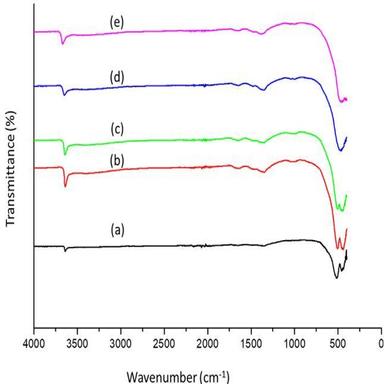
FTIR spectra of (a) Ni(OH)2, (b) Ni0.95Mg0.05(OH)2, (c) Ni0.9Mg0.1(- OH)2, (d) Ni0.75Mg0.25(OH)2 and (e) Ni0.5Mg0.5(OH)2.